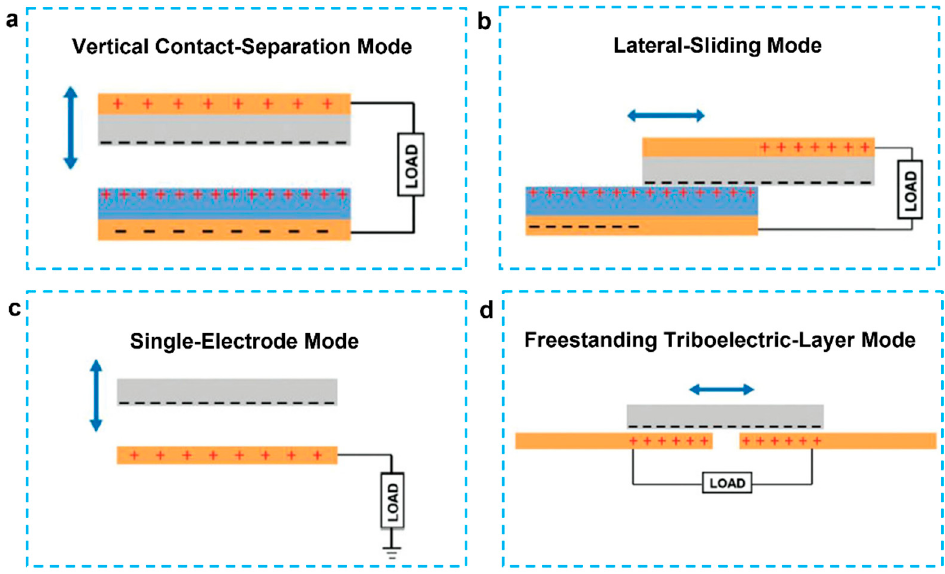
Figure 7. ( a ) Four working modes of TENGs. ( a ) Vertical contact-separation mode. ( b ) Lateral-sliding mode. ( c ) Single-electrode mode. ( d ) Freestanding triboelectric-layer mode [91]. Table 2. Comparison of performance of selected conducting polymer-based